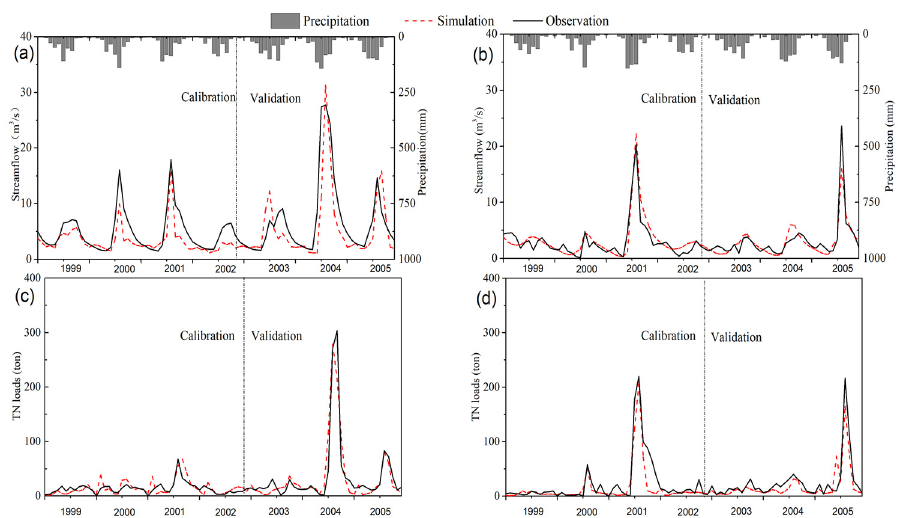
Figure 2. Observed and simulated daily streamflow and total nitrogen (TN) loads from 1999 to 2005. ( a ) The observed and simulated daily streamflow in Baihe River; ( b ) The observed and simulated daily streamflow in Chaohe River; ( c ) The observed and simulated total nitrogen in Baihe River; ( d ) The observed and simulated daily streamflow in Chaohe